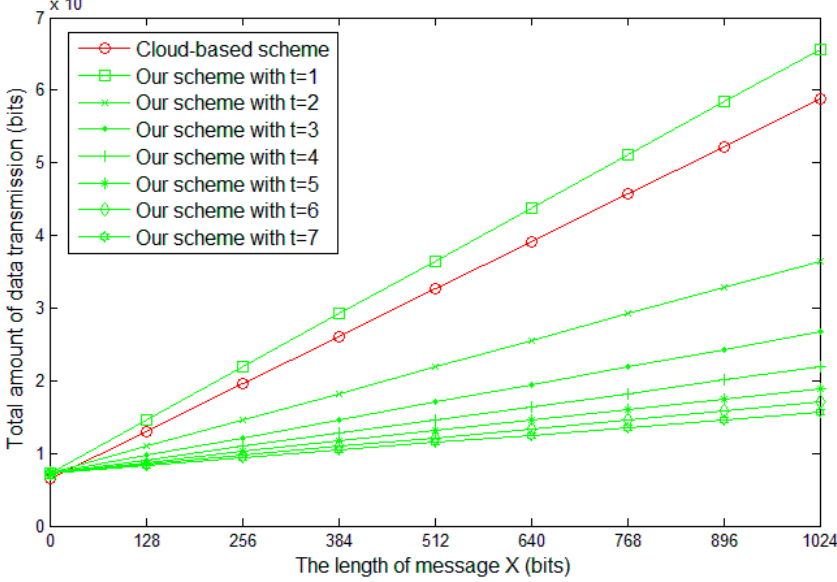
Figure 7. Total data transmission amount with different parameters.